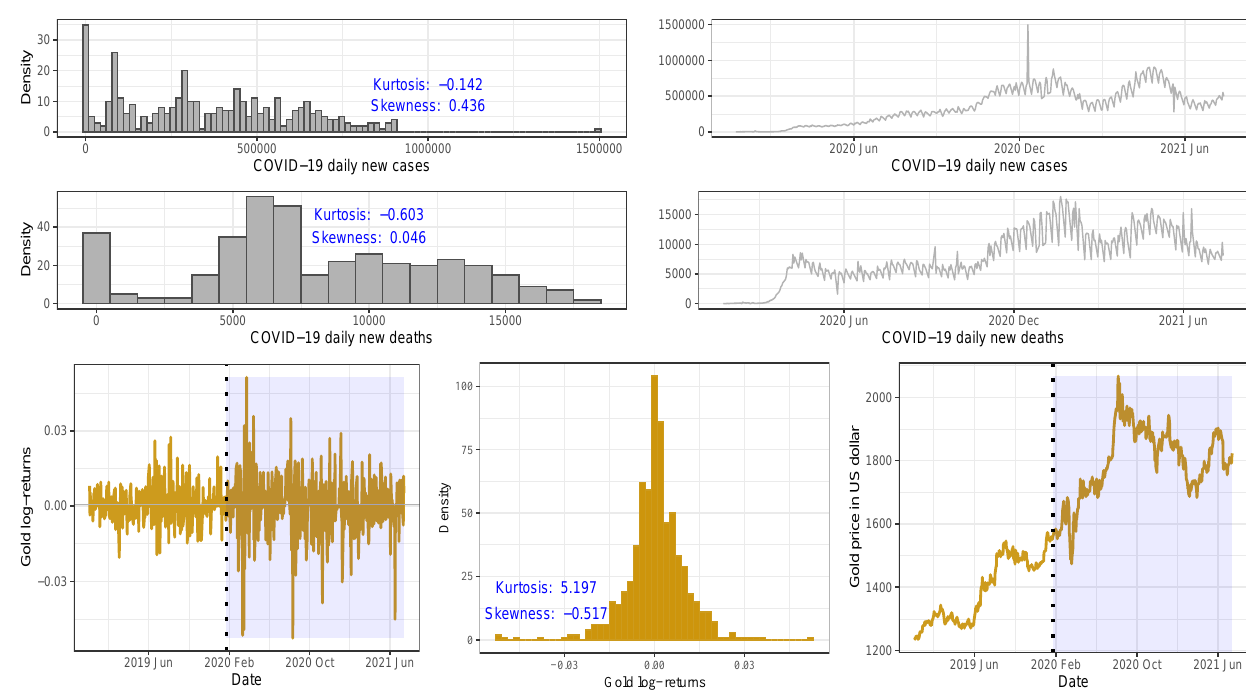
Figure 2. Probability density function and trend of daily (from 23 January 2020 to 01 July 2021) confirmed COVID-19 infections and deaths ( upper and middle ) and daily (from 04 December 2018 to 14 July 2021) returns ( lower left ), probability density function ( lowermiddle ), and prices ( lowerright ) of the gold. The vertical dotted line represents the threshold between the pre-COVID-19 period ( left ) and during the COVID-19 period ( right ) so that the shaded zone represents the period after the pandemic begins to visualize its impact on the gold